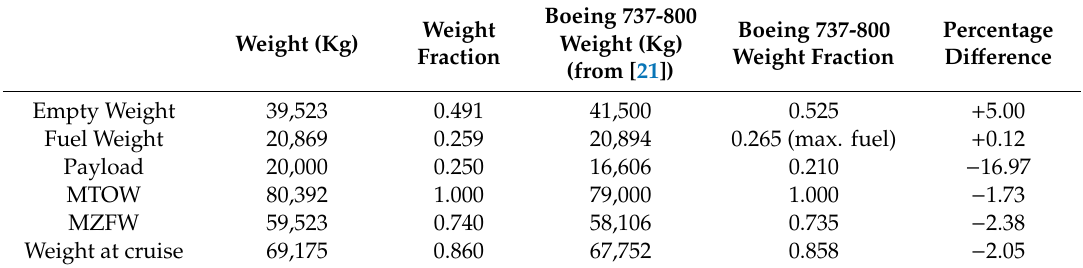
Table 2. Final weight